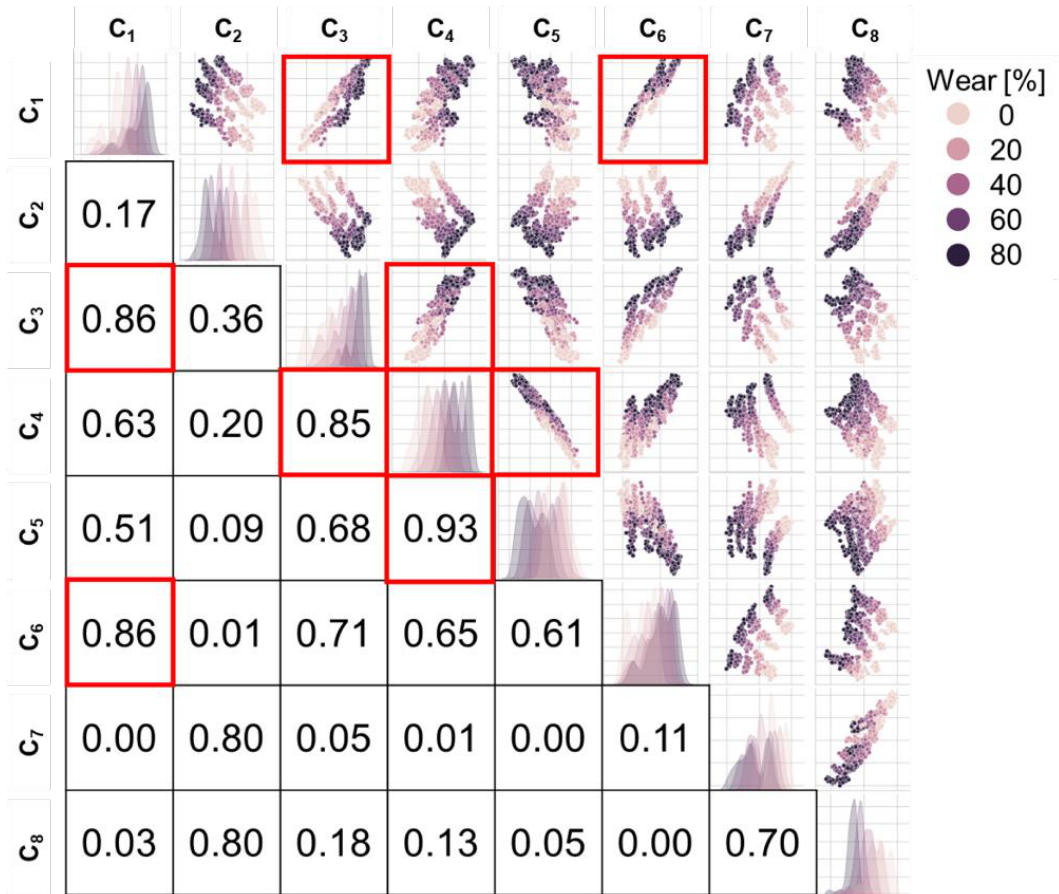
Figure 13. Pair plots between the eight features from 1D-CNN with wear amount. The pairs with coefficients of determination greater than 0.85 were indicated using squares.